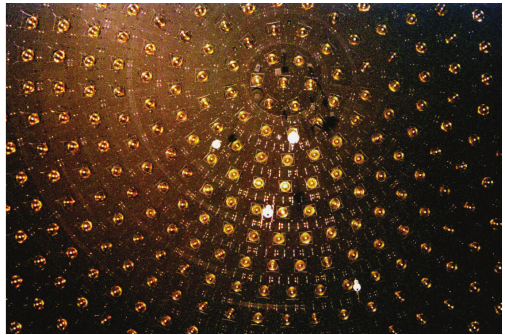
Figure 10: A photograph of the inside of the MiniBooNE